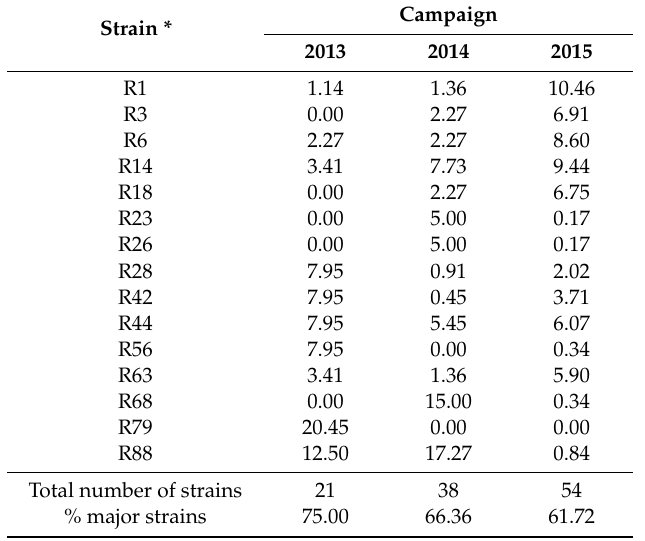
Table 4. Frequency of the main S. cerevisiae strains per